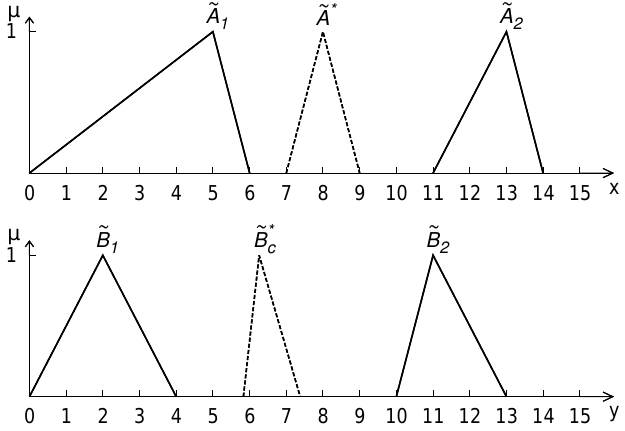
Figure 7. Interpolation for type-1 fuzzy sets